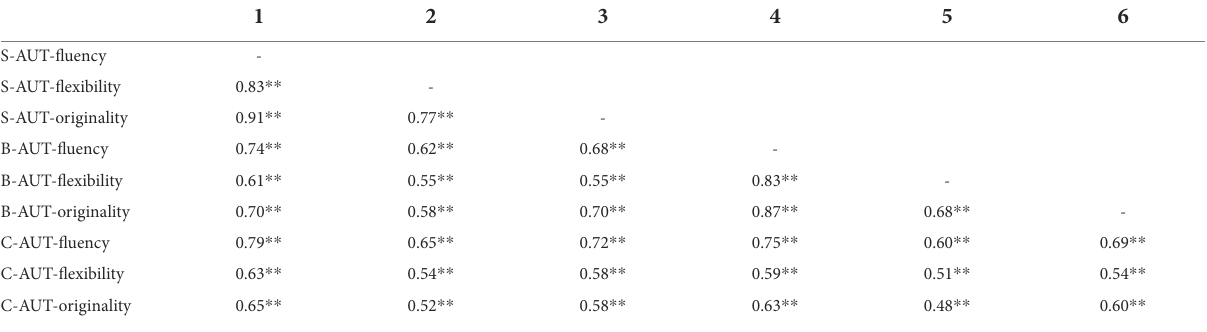
TABLE 4 Correlation coefficients among the three